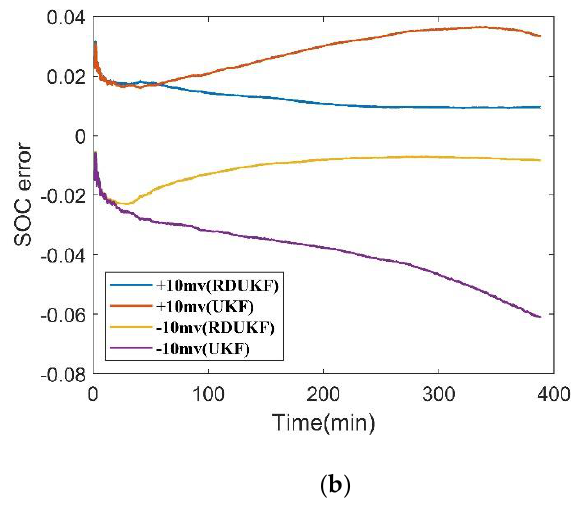
Figure 4. ( a ) SOC estimation results under different drift voltages; ( b ) SOC errors of the estimation results under different drift voltages.